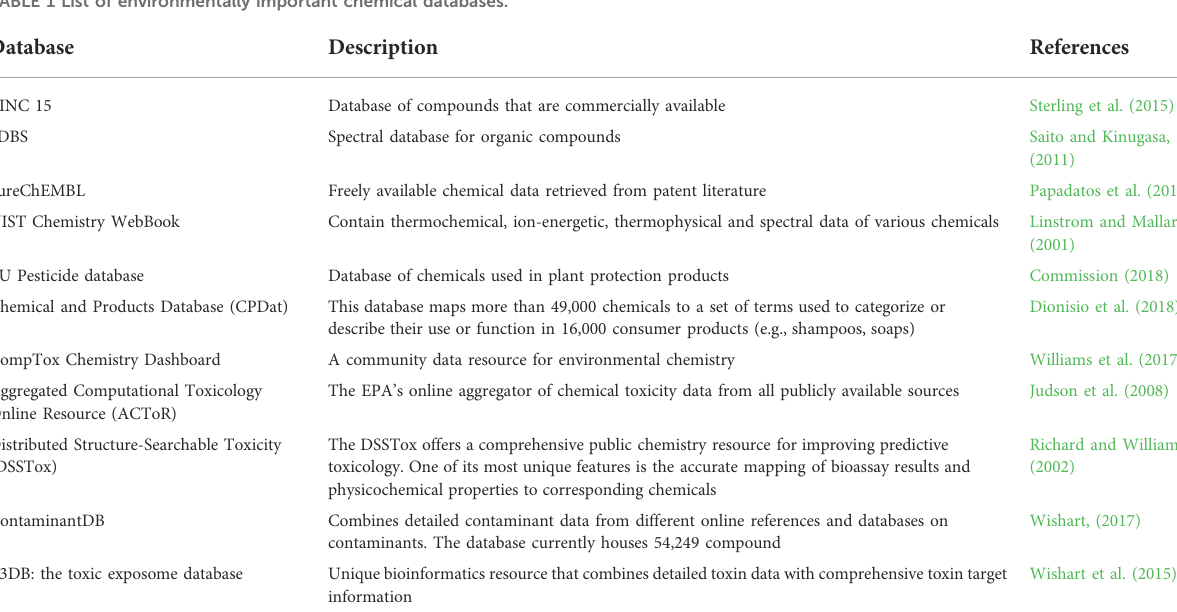
TABLE 1 List of environmentally important chemical